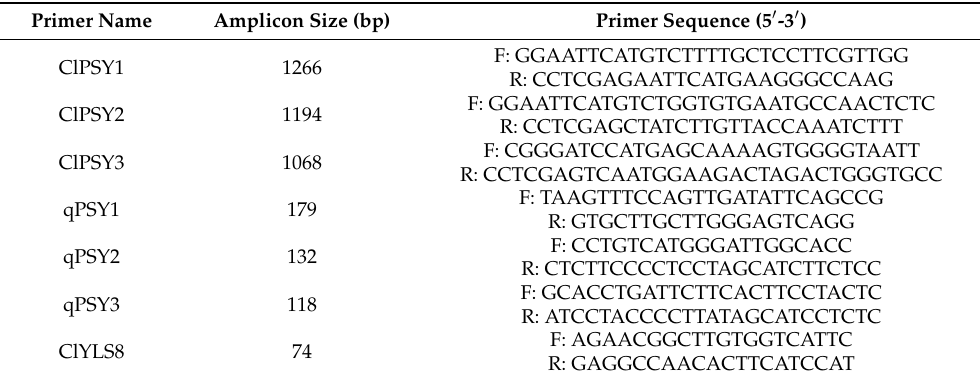
Table 2. Primers for amplifying the full-length cDNA and primers used for qRT-PCR